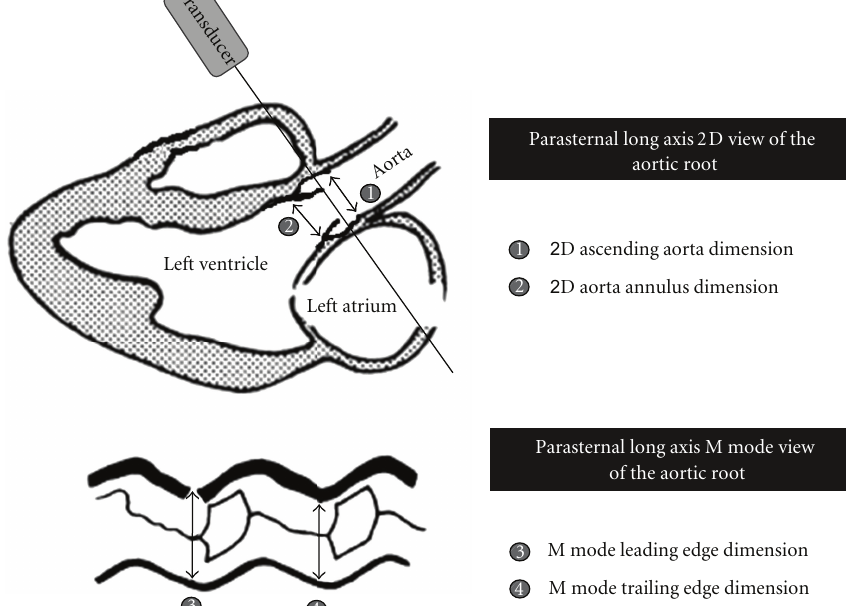
Figure 2: Methods of determination of LVO diameter. 2D ascending aorta dimensions are inner wall dimensions. 2D aortic annulus dimensions are taken at the valve hinges. Trailing edge technique measures the inner diameter of a vessel in M mode from the posterior portion of the anterior aortic wall to the inner boundary of the posterior aortic wall. Leading edge technique measures from the anterior portion of the anterior aortic wall to the inner boundary of the posterior aortic